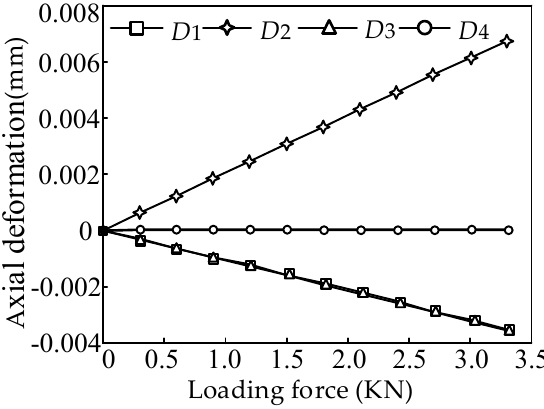
Figure 18. Axial deformations of the four branches.